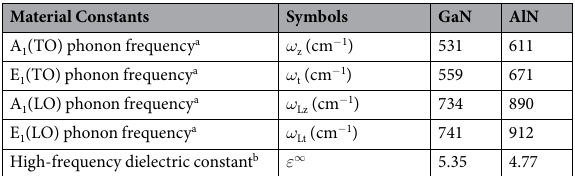
Table 1. Material constants used in the numerical calculations. a Phonon frequencies taken from ref. 17 . b Dielectric constants taken from ref. 18